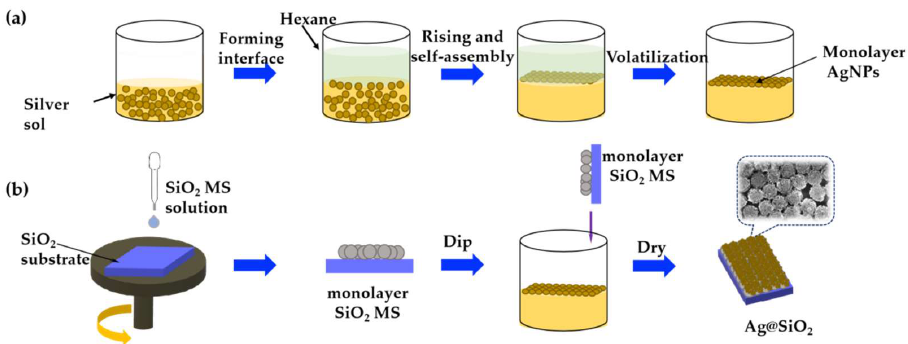
Figure 1. Preparation process of ( a ) monolayer AgNPs and ( b ) Ag@SiO 2 substrate.